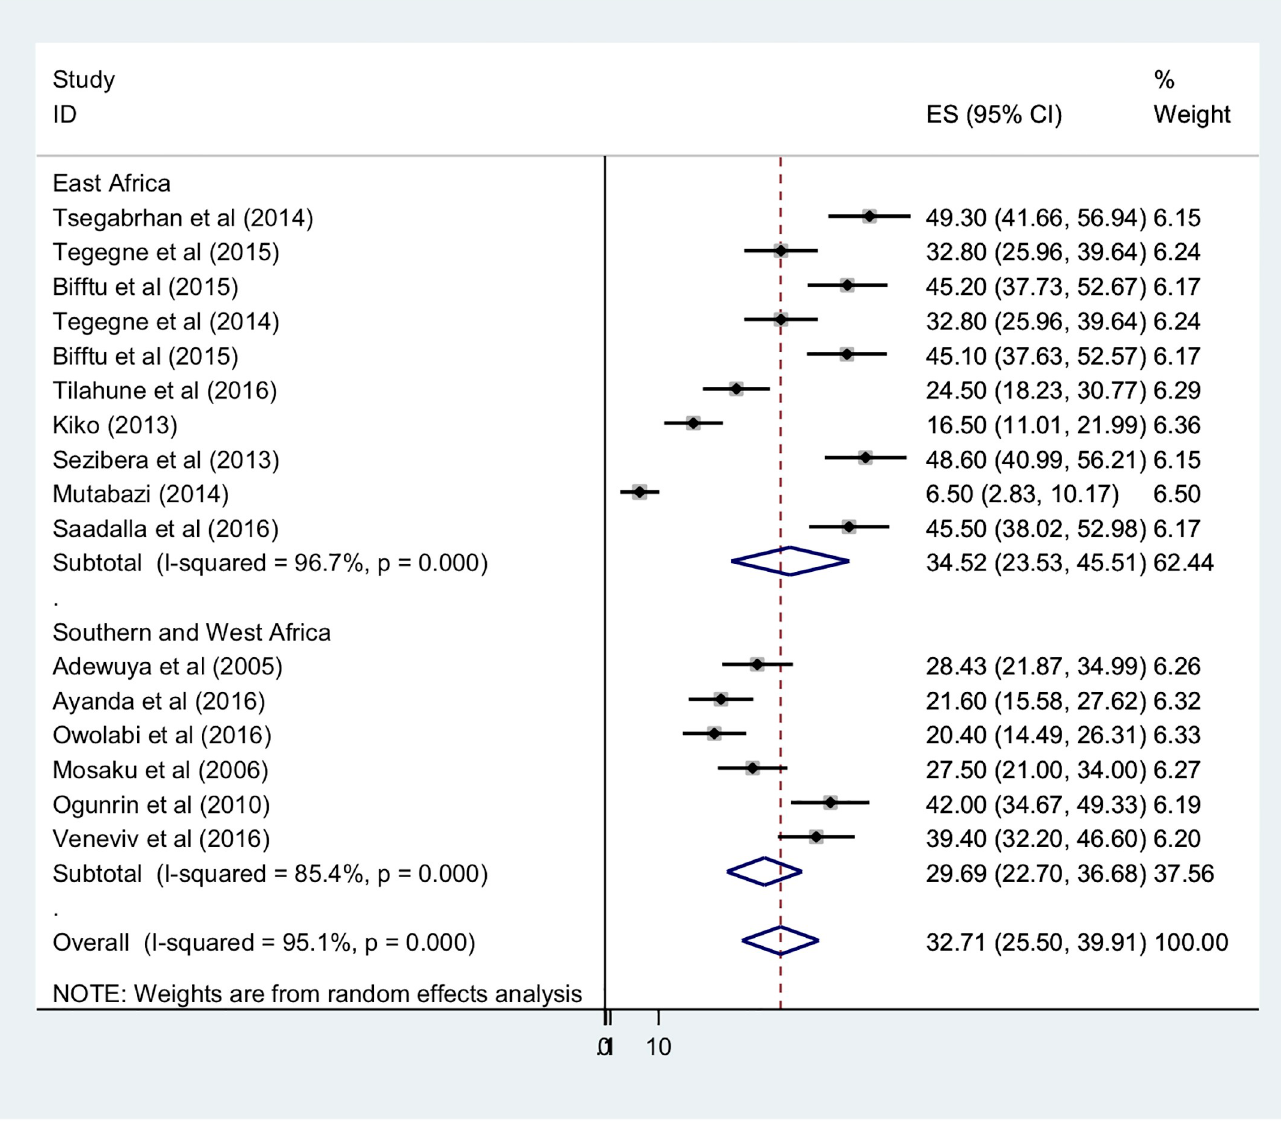
Fig 3. Forest plot of 16 studies assessing prevalence of depression among epilepsy patients, 2005–2017, sub-Saharan